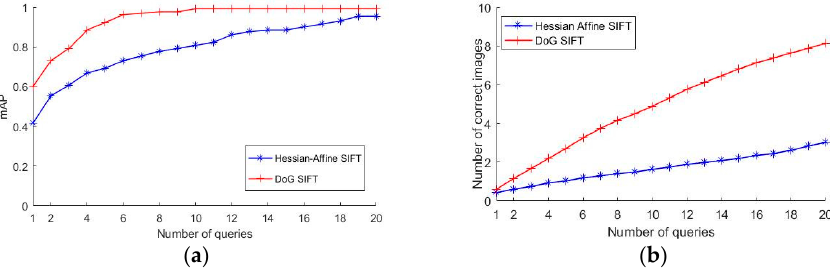
Figure 5. Comparison between Hessian affine and DoG detectors. ( a ) mAP ( b ) average number of correct images in the top-K queries.